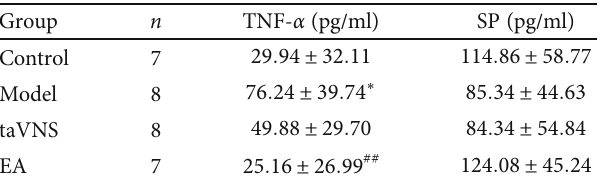
group. Table 5: Comparison of plasma concentration of TNF- α and SP in each group at 28 day ( (cid:1) x ± s